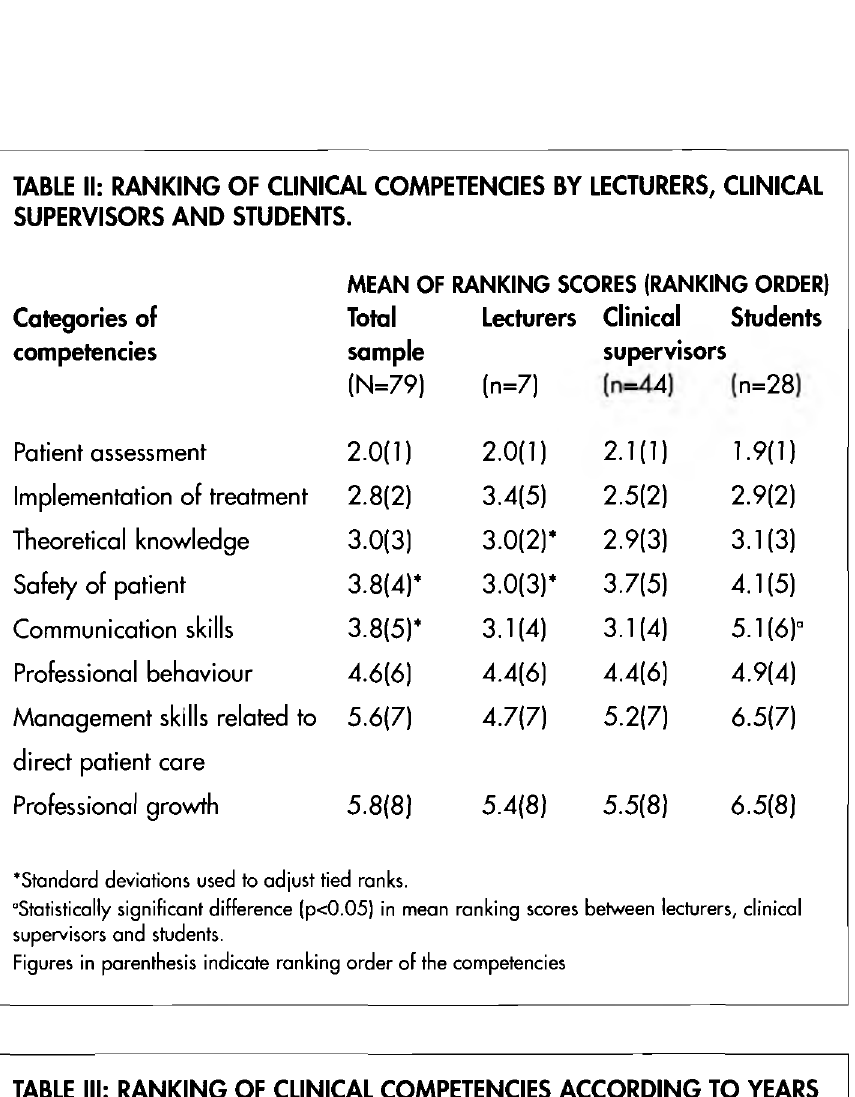
TABLE III: RANKING OF CLINICAL COMPETENCIES ACCORDING TO YEARS OF CLINICAL EXPERIENCE.